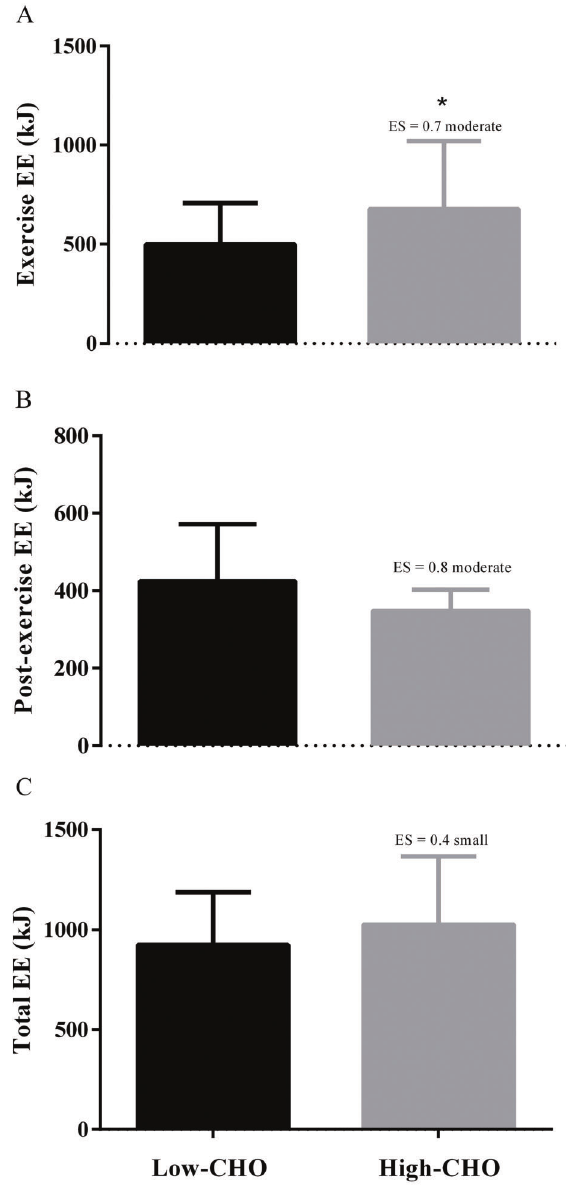
Figure 4. Energy expenditure (EE) during ( A ) and after ( B ) a . single, high-intensity exercise bout ( B 95% VO 2max ) performed under low- and high-carbohydrate (CHO) availability. Total energy expenditure (exercise plus post-exercise) is also shown ( C ). Data are reported as means ± SD (n=8). *P o 0.05 compared to low- CHO availability, moderate effect size (ES=0.7) ( t